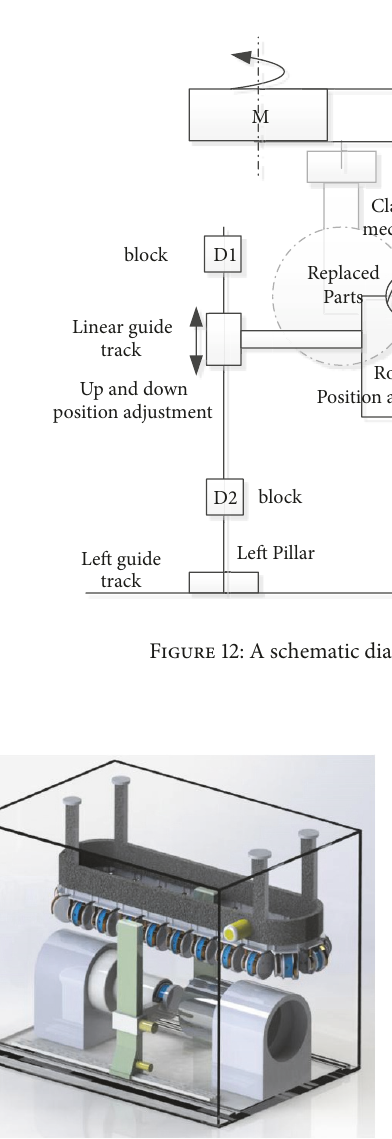
Figure 13: 3D model